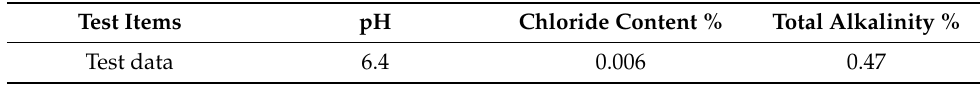
Table 3. Performance test results of water reducing agent.